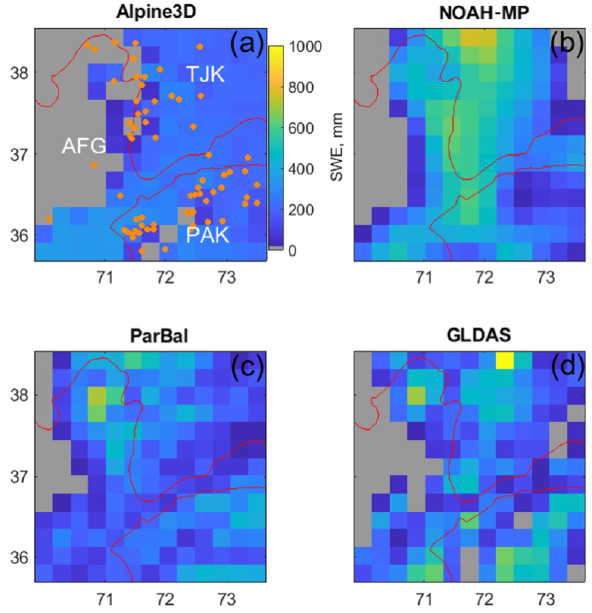
Figure 7. Four-model (a–d) spatial comparison for the study area on 4 May 2018. The white letters represent the following: AFG – Afghanistan; TJK – Tajikistan; and PAK – Pakistan. Also shown in (a) are the locations of the AKAH stations (orange points). This is a frame from a video sequence available in the